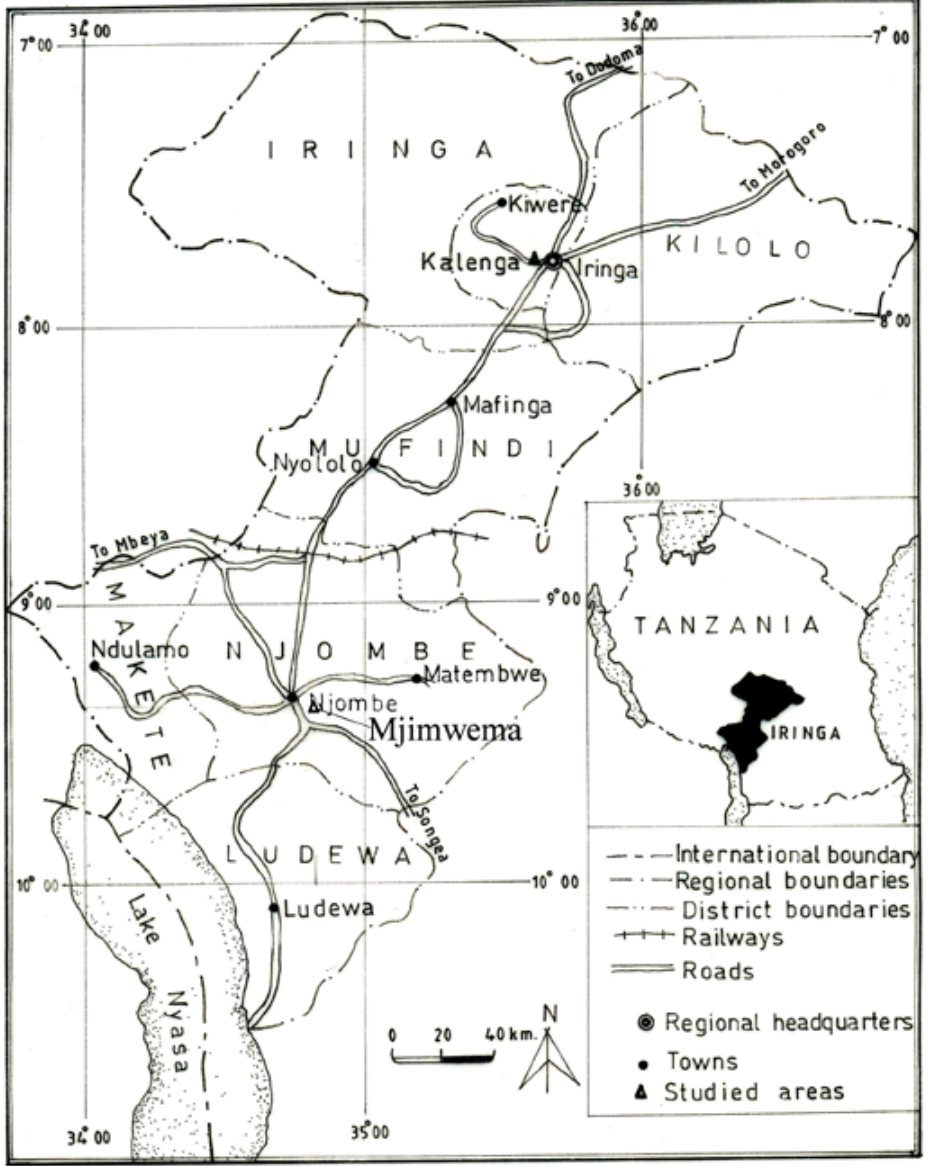
Fig1: The location of Mjimwema in Njombe